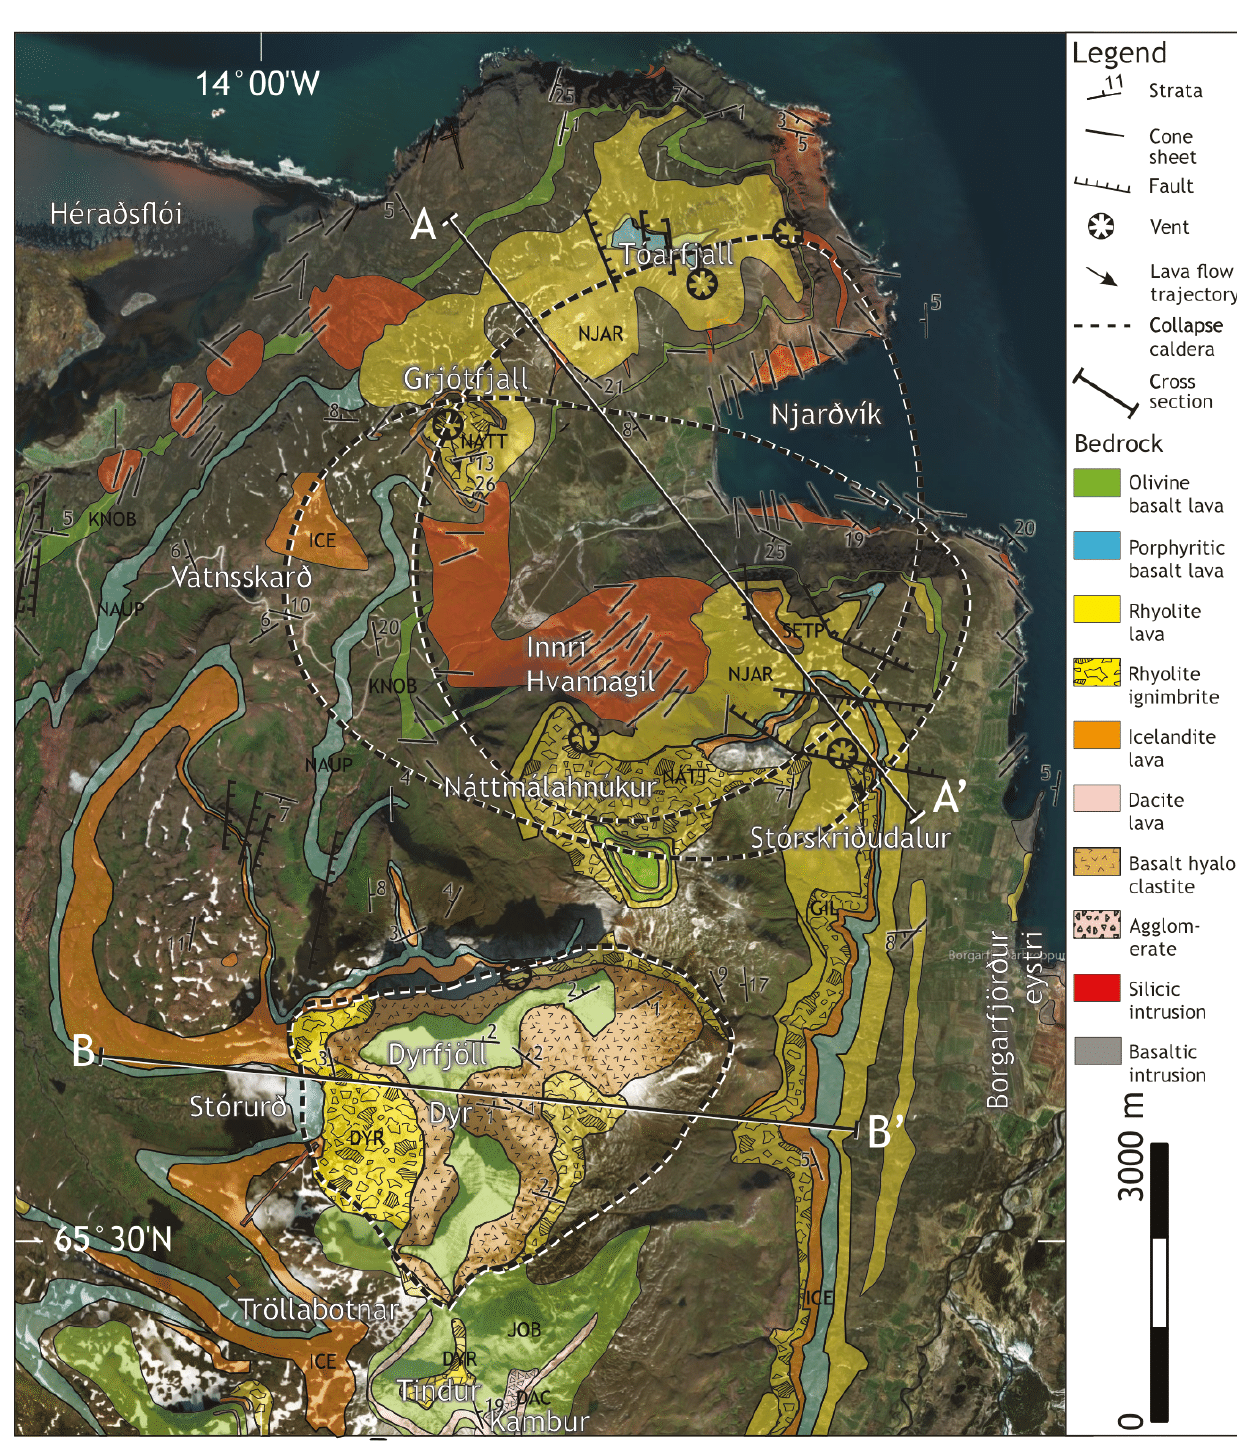
Figure 4: Geological map of Njarðvík and Dyrjöll. For location, see Figure 3. Satellite image from 2009 accessed through Bing Maps ( https://www.bing.com/maps ). For the cross sections A–A (cid:48) and B–B (cid:48) , see Figure 13. For names of stratigraphic formations, see text and Figure